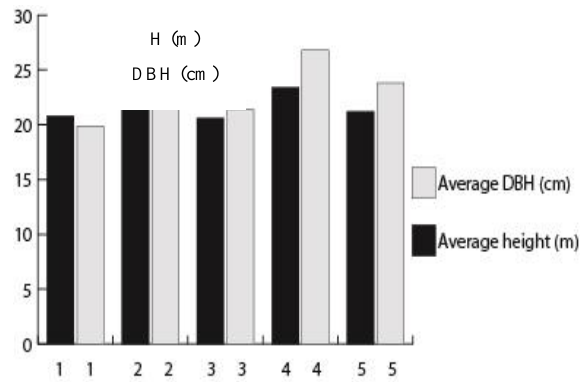
Figure 2. H and DBH data of 35-year-old black locust cultivars as a mean of